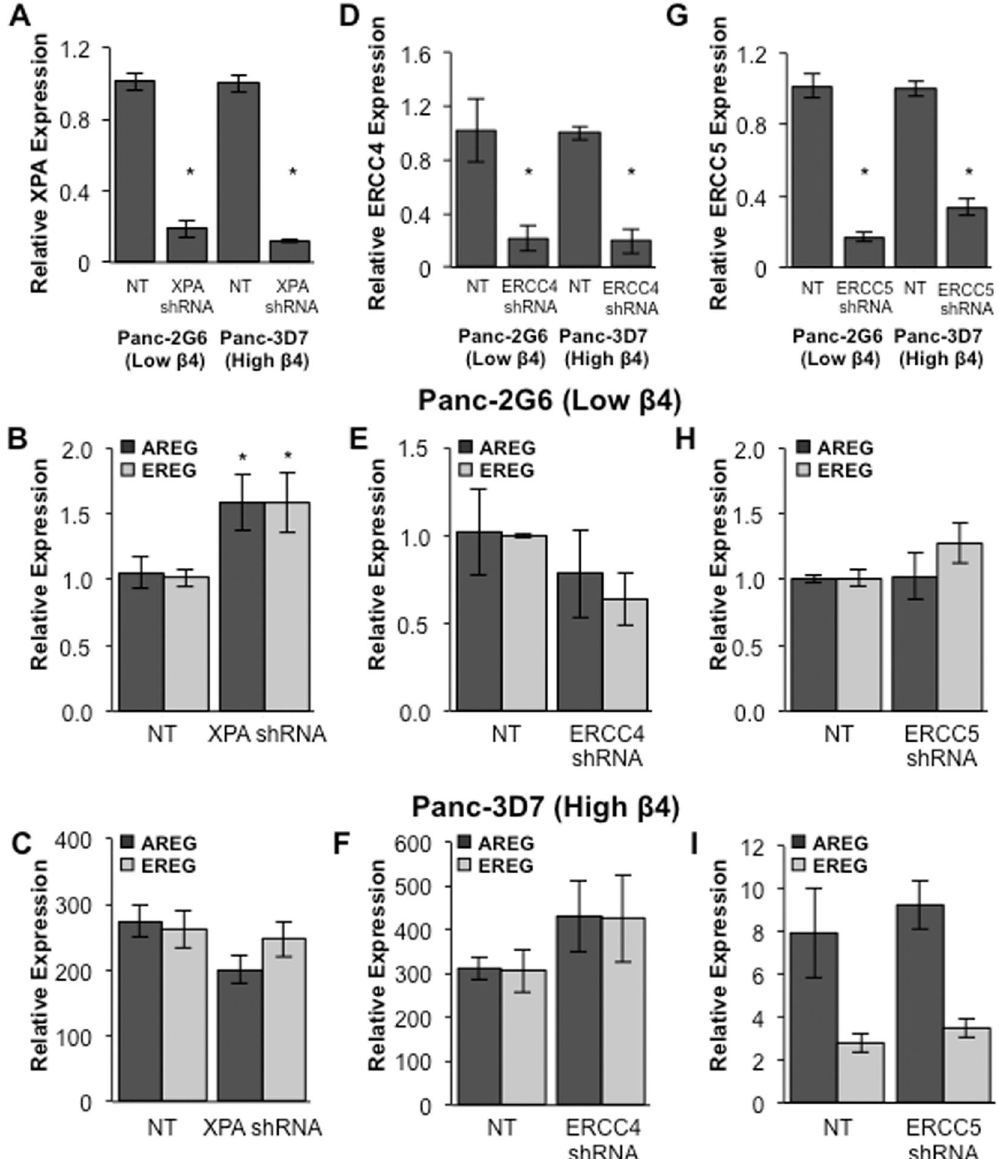
Figure 4. NER is not required for expression of AREG and EREG. Using lentiviral transfection stable knockdown of XPA ( A ), ERCC4 (XPF) ( D ), and ERCC5 (XPG) ( G ) was achieved in Panc1-2G6 (low α 6 β 4) and Panc1-3D7 (high α 6 β 4) cells as confirmed by QPCR. AREG and EREG expression was examined following knockdown in cells with both low α 6 β 4 ( B , E , H ) and high α 6 β 4 ( C , F , I ) expression. Data depicted are representative of at least three different experiments and represent the mean + / − standard deviation. Statistical significance was calculated using a one-tailed t-test in which * denotes P < 0.05 as compared to